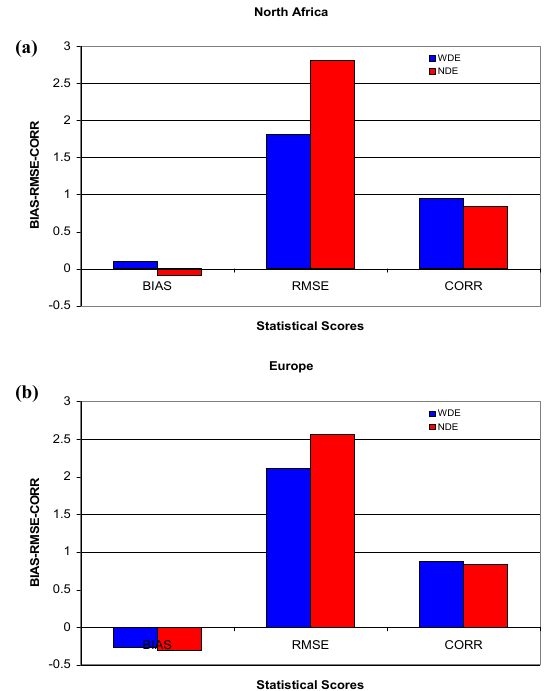
Fig. 7. Statistical parameters: Bias, RMSE and correlation coeffi- cient for the spring period of the simulations (March-April-May) with dust effects (WDE) and without dust effects (NDE) for the surface temperature for North Africa (a) and Europe (b)